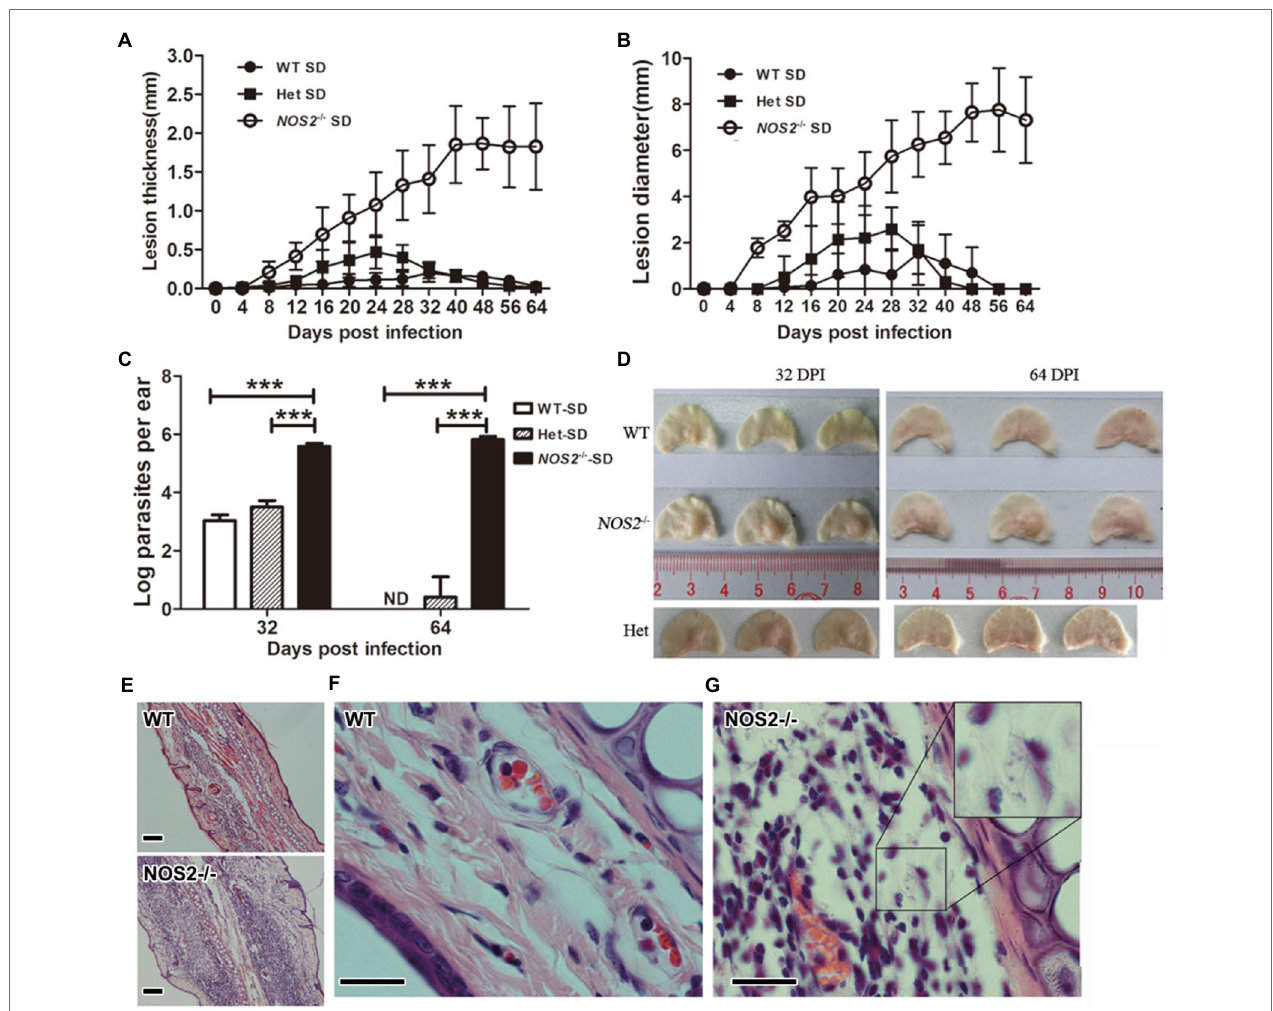
FIGURE 2 | Rats deficient in NOS2 are susceptible and parasites were not controlled. Wild-type (WT), heterozygous (Het; N = 12), and Nos2 − / − ( Nos2 − / − ; N = 12) SD rats were subcutaneously infected with 10 7 l . amazonensis LV78 in the left ear. Lesion thickness (A) , and diameter (B) were shown as mean ± SD. 0–32 days postinfection (DPI), N = 12; 40–64 DPI, N = 6. The parasite load (C) in the lesion was determined by limiting dilution assay ( N = 3, mean ± SD). The outlook of representative infected ears (D) . (E–G) , HE-stained sections of infected ear at 32 DPI. Inset in G shows multiple amastigotes. Scale bar, 20 μ m. ND: not detectable (﹤20). *** indicates a significant difference ( P ﹤